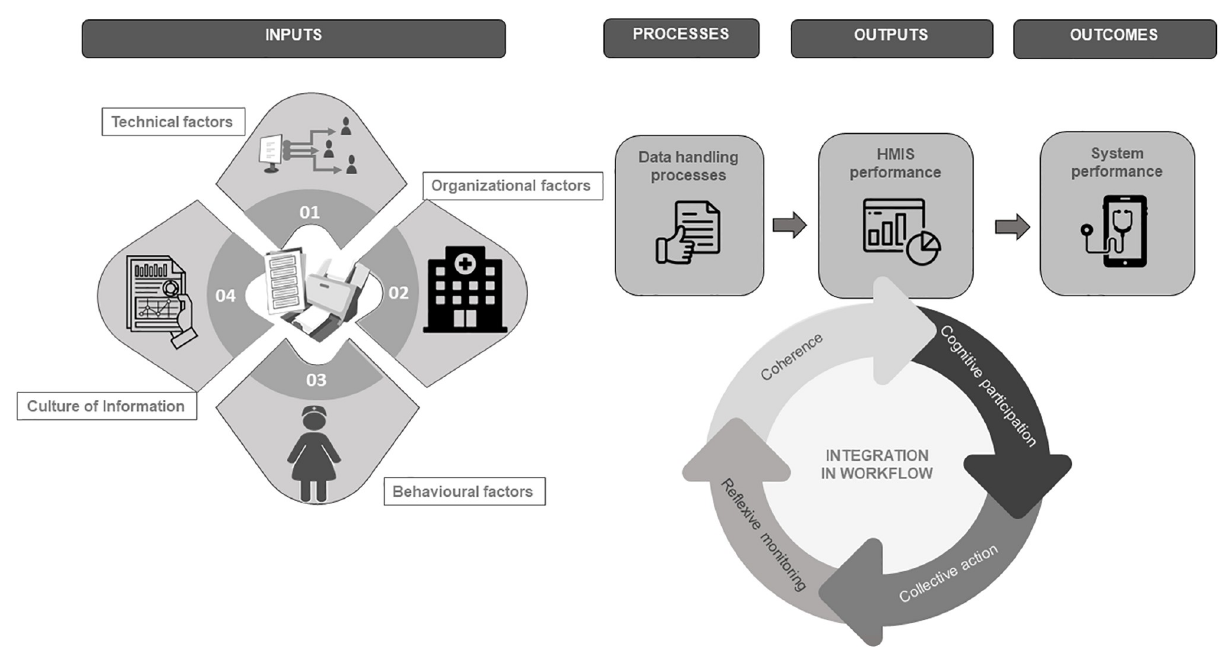
Fig 3. Factors influencing the use of digital technology to impact documentation processes, outputs and